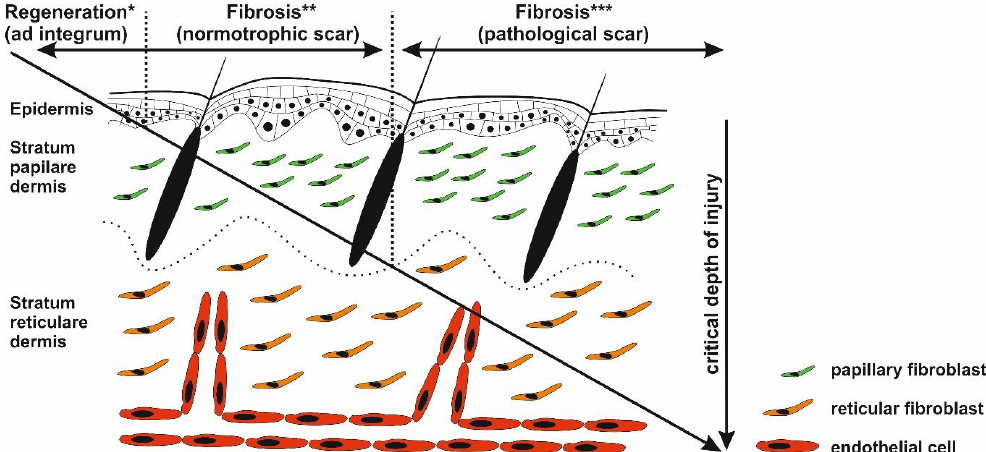
Figure 2. Critical depth of injury. Only the epidermis has the capability to fully regenerate (*), whereas healing of the injured dermis results in scar formation (** and ***). Injury targeting only papillary dermis ends with normotrophic scar formation (*). Deeper wounds (reticular parts of the dermis) with prolonged inflammatory response may activate biological pathways resulting in pathological scarring (***).